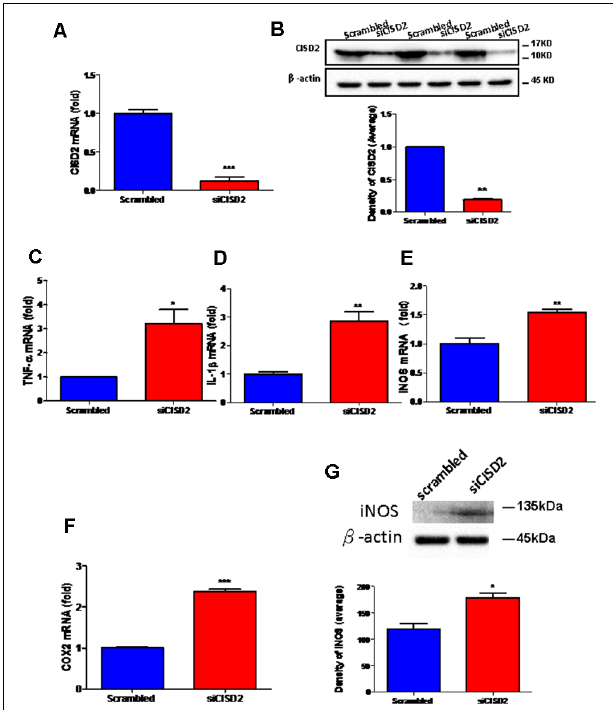
FIGURE 1 | Knockdown of CISD2 expression augmented tendency for M1 microglial polarization and enhanced proinflammatory response in non-stressed EOC microglial cells. The conditions were set as follows: (i) scrambled RNA-transfected control cells; (ii) siCID2-transfected cells. (A) Confirmation of knockdown efficiency of CISD2 mRNA and protein (B) expression in microglia. (C) Expression of TNF- α mRNA, (D) IL-1 β mRNA, (E) iNOS mRNA, and (F) COX2 mRNA under all conditions. (G) iNOS protein expression in siCID2-transfected EOC microglial cells. The upper panel demonstrates the immunoblot results of iNOS at 135 kDa, and β -actin (45 kDa) serves as an internal control; the lower panel indicates the mean ( ± SEM) of iNOS/ β -actin band intensity in ratio with the control group. Vertical bars indicate the mean ± (SEM) of mRNA or protein expression ( n = 3). * p < 0.05; ** p < 0.01; *** p < 0.001 indicate statistically significant difference when compared to scrambled control